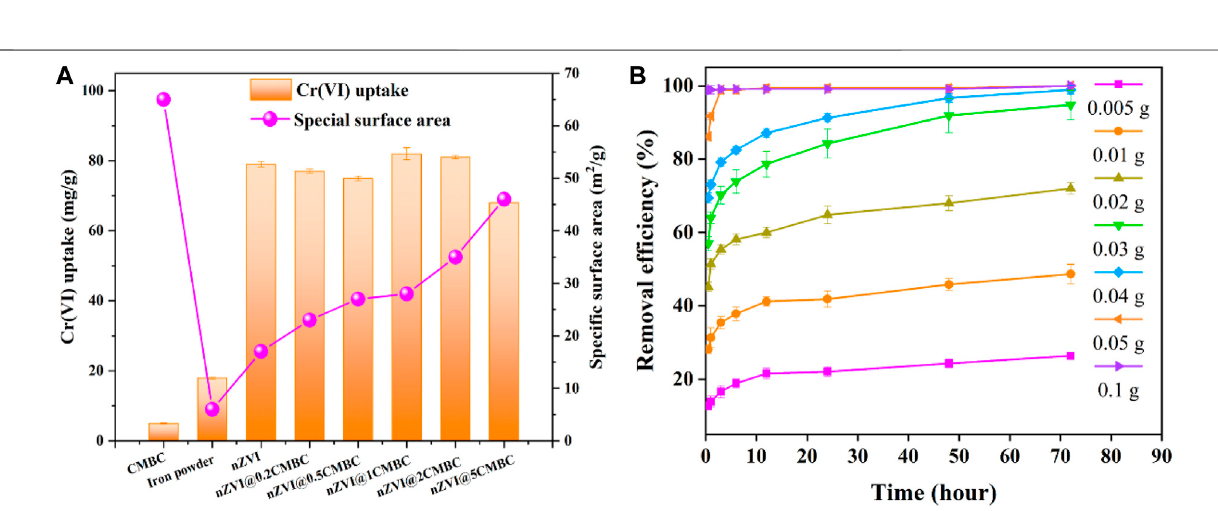
Frontiers in Bioengineering and Biotechnology |